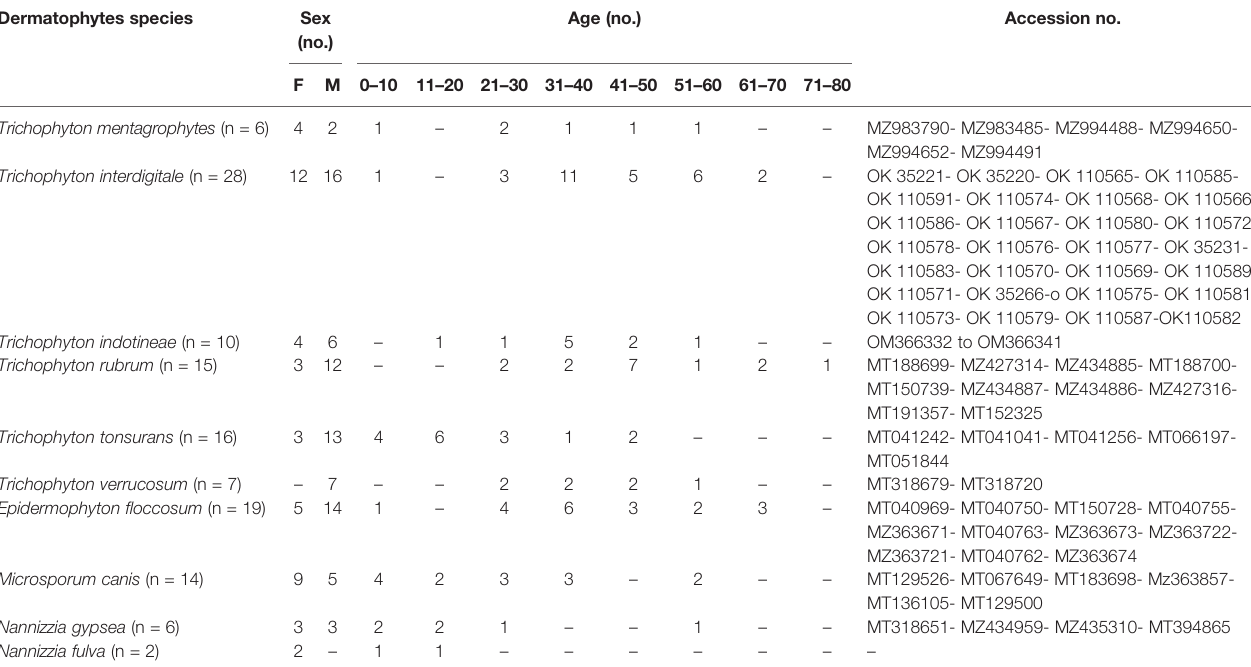
TABLE 2 | Age and sex distribution of dermatophyte species isolated from clinical specimens. Dermatophytes species Sex